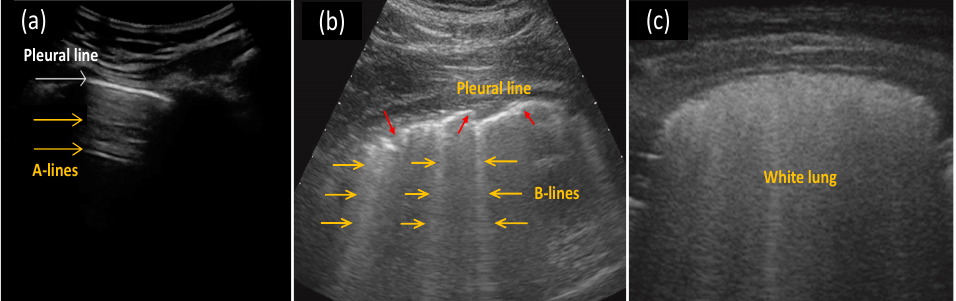
Figure 3. Examples of ( a ) horizontal A-lines (yellow arrows) in a normal lung, ( b ) multiple B-lines (yellow arrows) with an irregular pleura line (red arrows) in a COVID-19 indicative lung, and ( c ) white lung (completely diffused B-lines) for severe COVID-19 pneumonia. Reprinted with permission from ref. [34,51]. Copyright 2020 John Wiley and Sons.